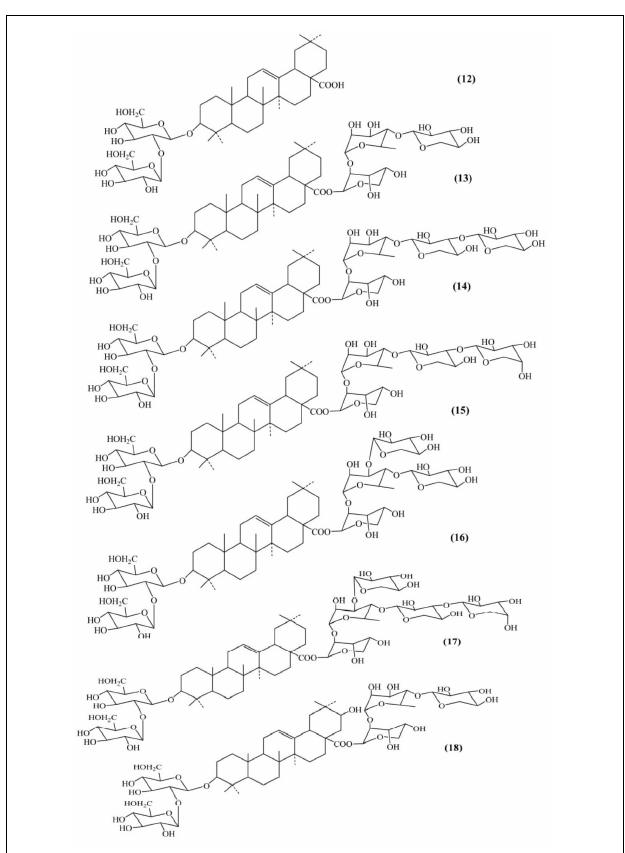
FIGURE 4 | Saponin